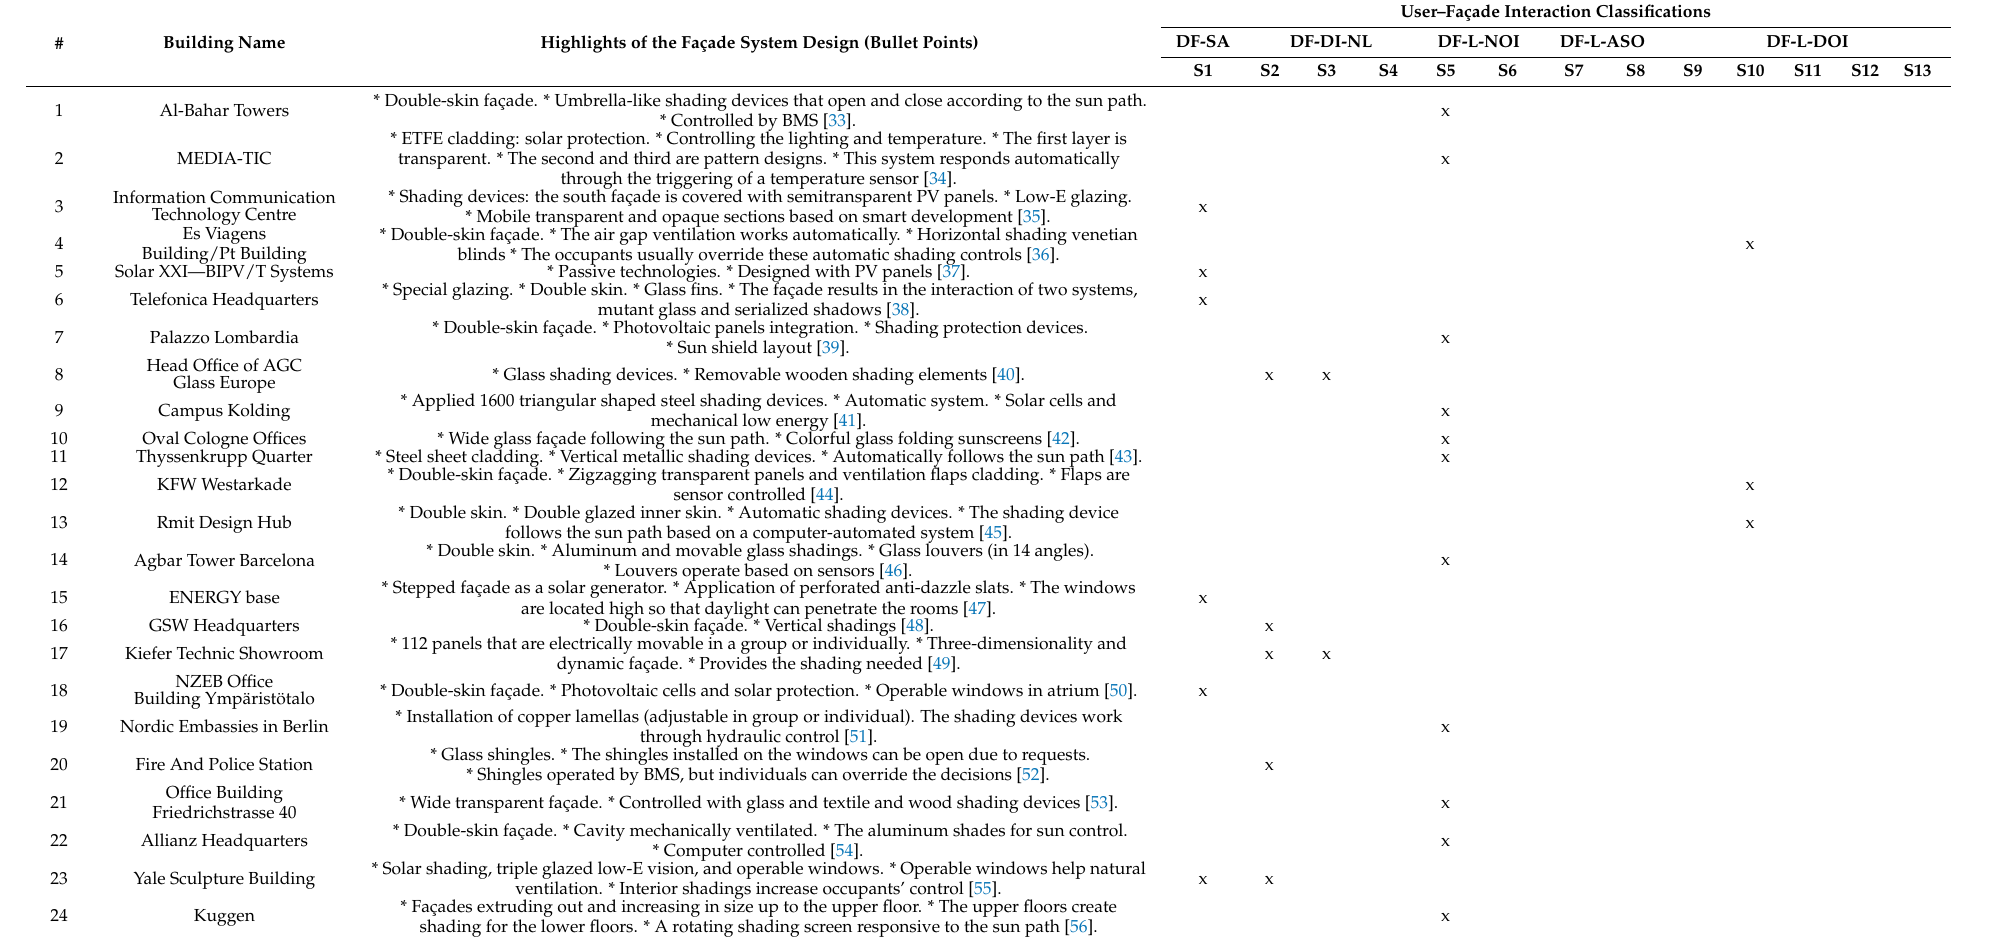
Table 4. CABS office building façade-system analysis based on user–façade interaction types and scenarios (Authors,